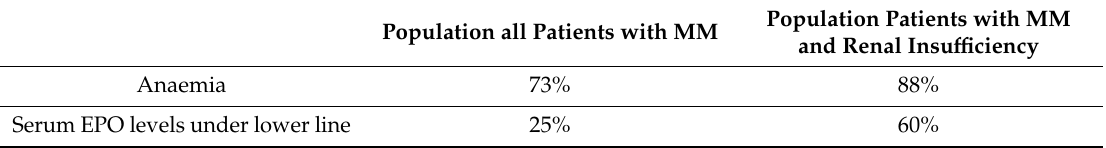
Table 1. Anaemia in multiple myeloma (MM) and kidney